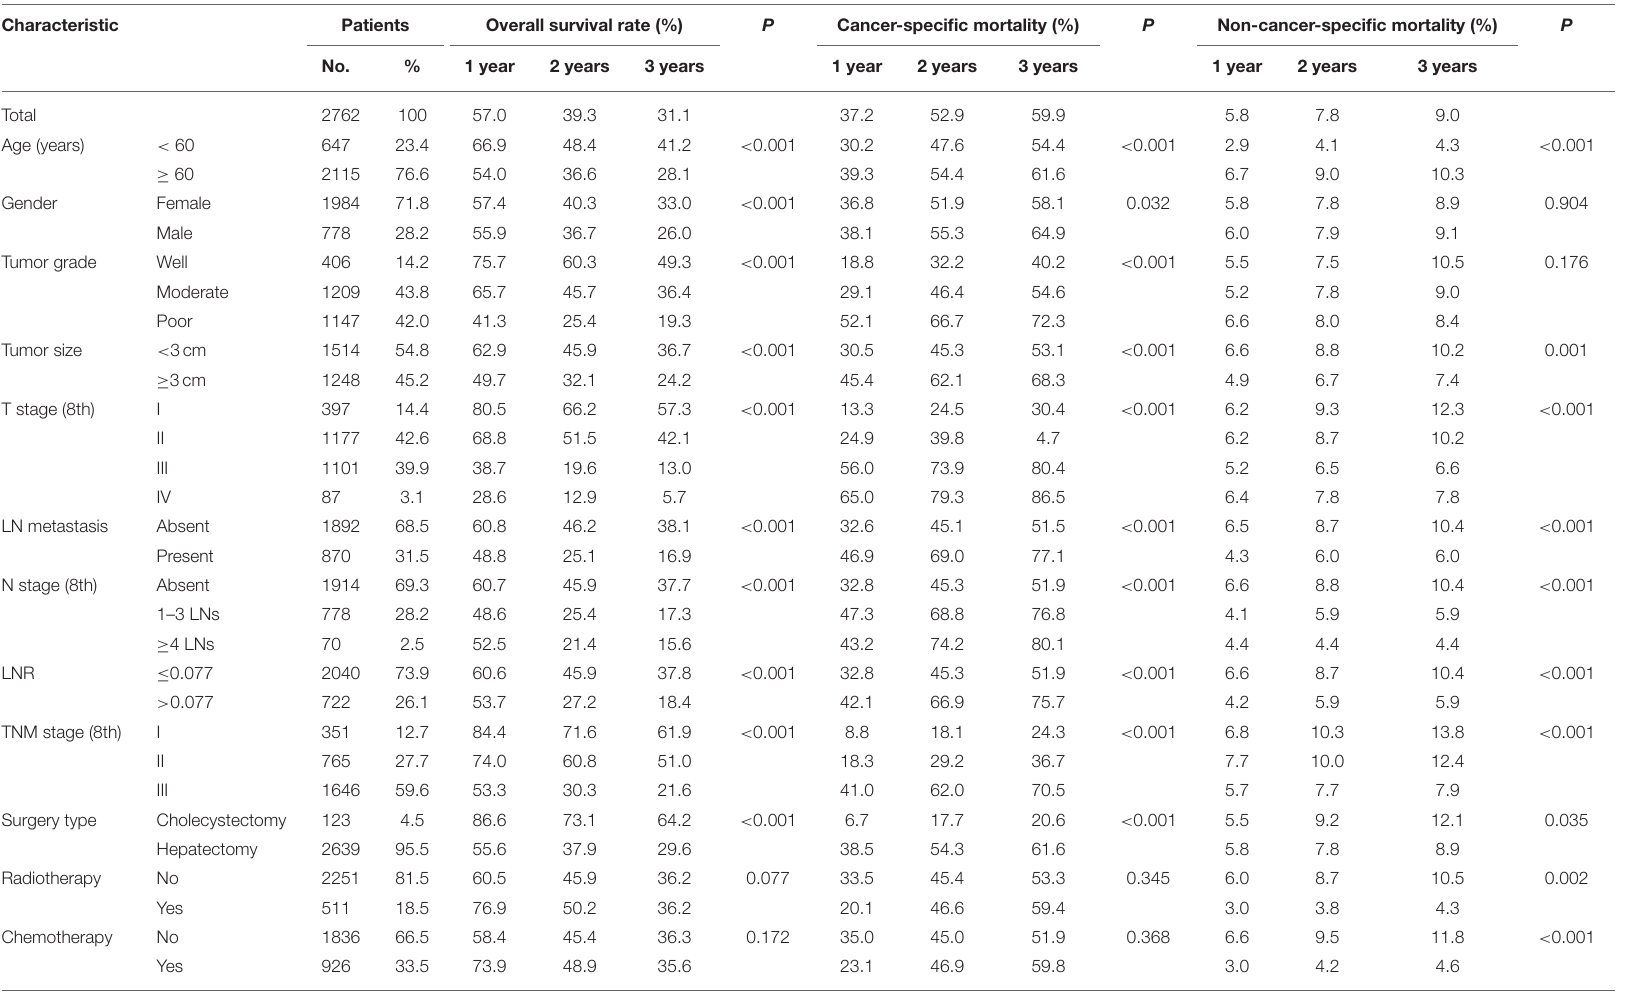
TABLE 1 | Overall survival rates and cumulative incidences of mortality among patients with gallbladder carcinoma. Characteristic Patients Overall survival rate (%) Cancer-specific mortality